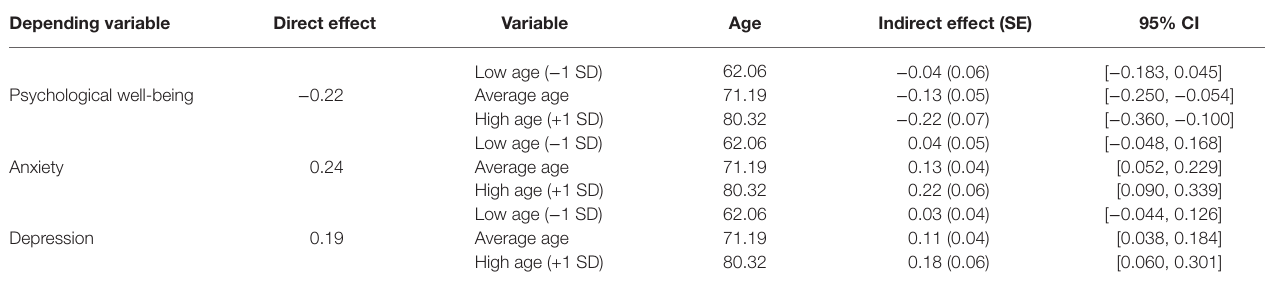
TABLE 2 | Results for conditional indirect effect of self-concept differentiation on psychological adjustment through self-consistency and congruence. Depending